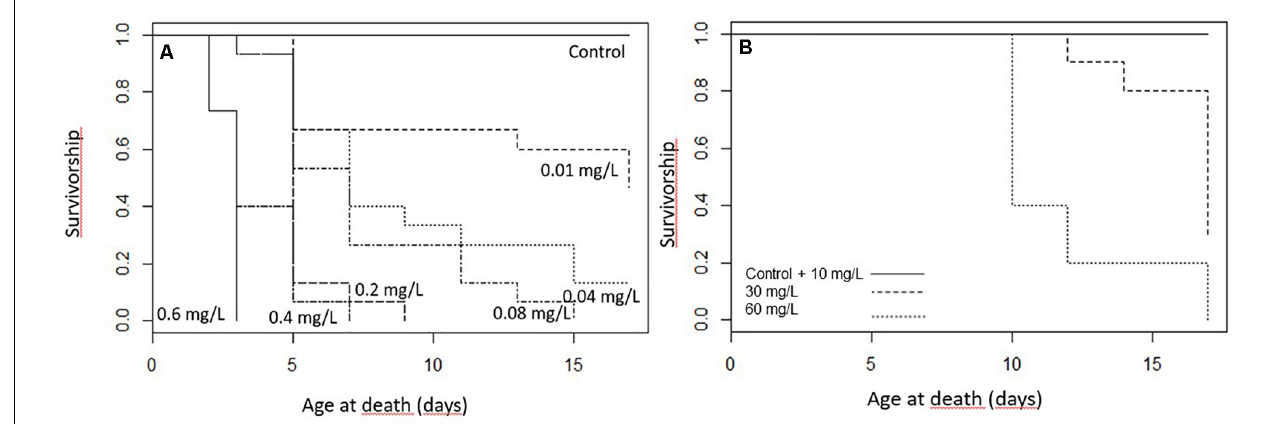
FIGURE 1 | The survivorship of the caterpillars during the treatment (A) Spinetoram treated larvae (0.6 mg/L, 0.4 mg/L, 0.2 mg/L, 0.08 mg/L, 0.04 mg/L, and 0.01 mg/L) and the control group, (B) larvae treated with 10 mg/L, 30 mg/L, and 60 mg/L Azadirachtin and the control group.